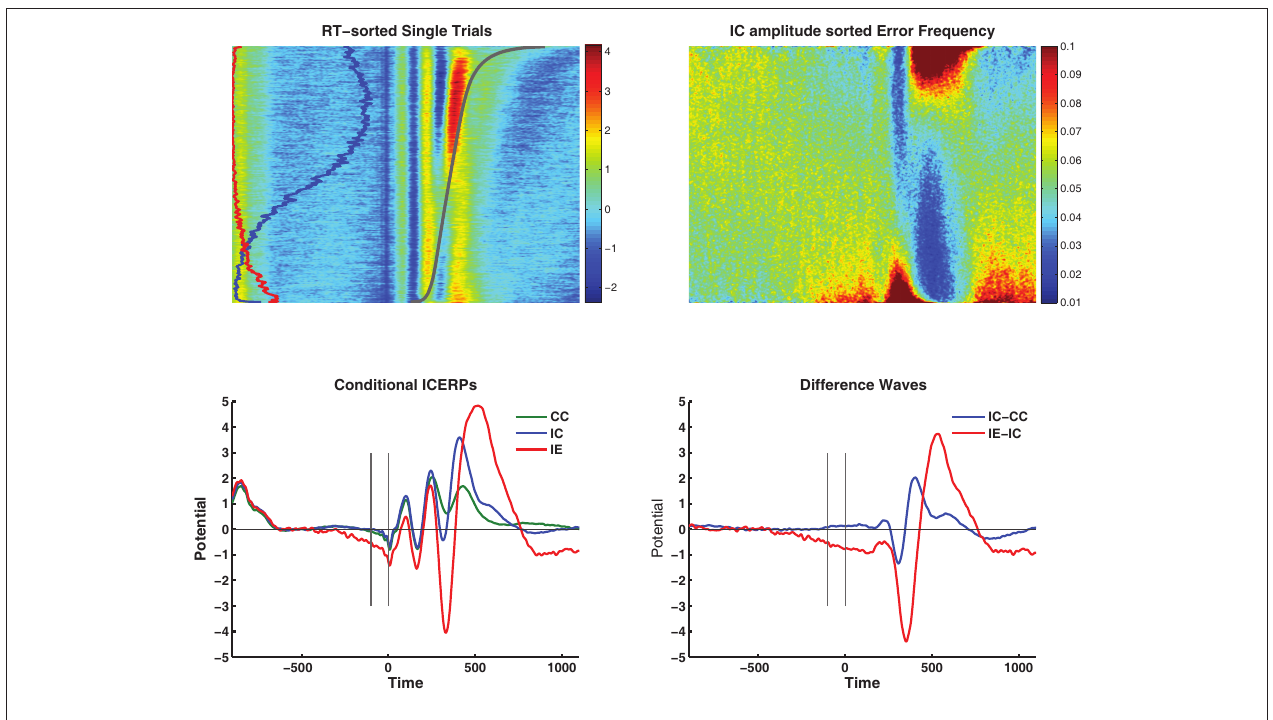
rates in red, and lower than error rates in blue (equivalent to “vincentizing”). The dominant feature in the figure is the scaling of error rate with increasing negative amplitudes during the N2/ERN latency and during the pre-stimulus negativity, and inversely during the P3/Pe latency range. Bottom left: conditional ICERPs for compatible correct (CC, green), incompatible correct (IC, blue), and error responses (IE, red). Bottom right : difference waves for incompatible correct minus compatible correct (blue) and incompatible errors minus incompatible correct